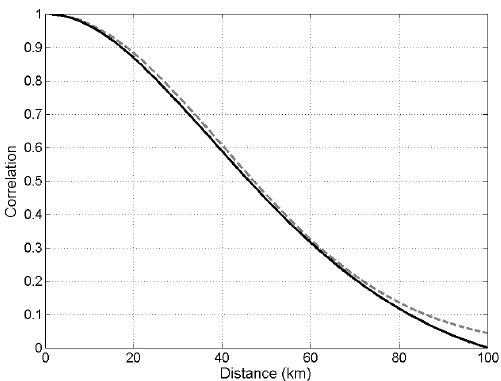
Figure 4. Correlation curve computed for altimetric data (black solid line) for a typical zonal scale of correlation for the Mediter- ranean region of 100km. The grey dashed line shows the best-fitting correlation curve obtained for the reconstruction experiments. It corresponds to a spatial scale of correlation of 40km.